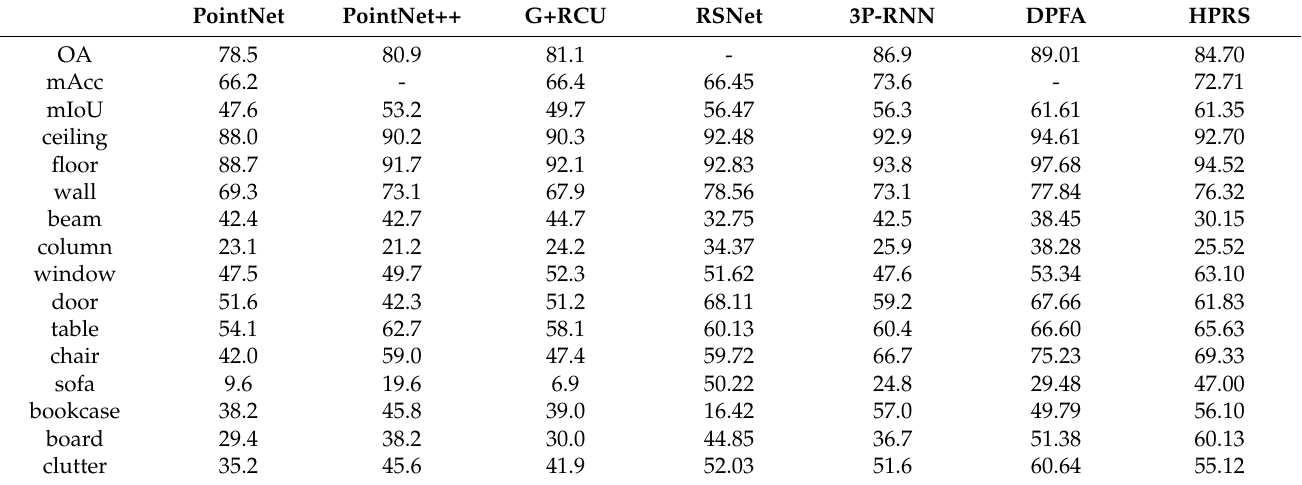
Table 4. Quantitative results of different approaches for the S3DIS dataset under 6-fold cross-validation